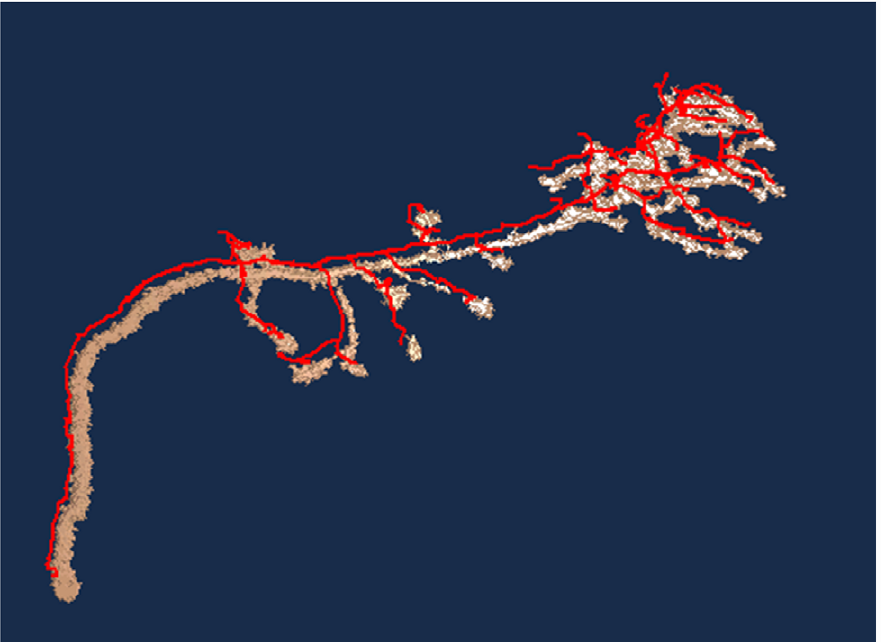
Figure 8. The traced result ( red ) of the contaminated, s =60 image stack overlaps with the volume rendering of the image stack.